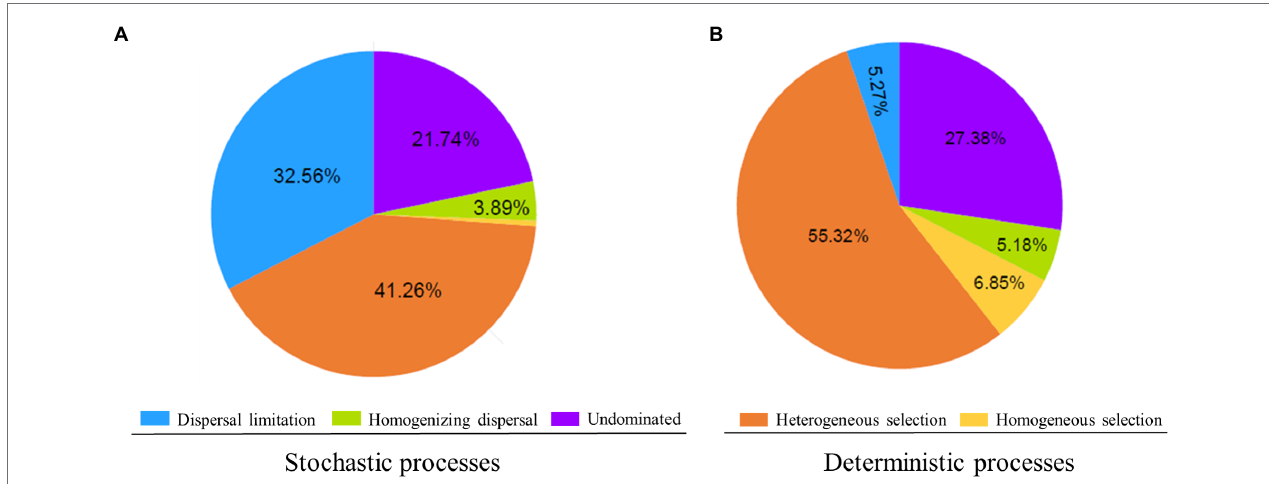
FIGURE 5 | Delineation of the assembly processes underlying the core (A) and satellite (B) bacterial sub-communities. The percentage of turnovers governed by a process is used to represent its relative importance in community assembly. Low percentage contributions (<1.5%) are not